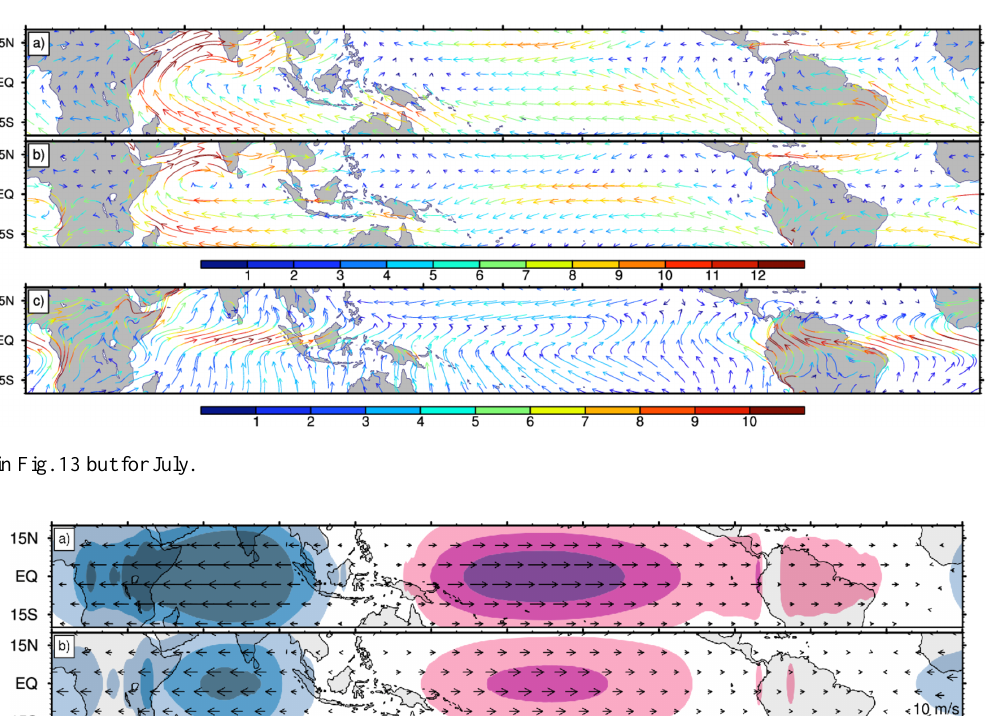
Figure 16. Climatological Kelvin wave in ERA Interim for July on (a) model level 27, at about 133hPa and (b) and model level 31, at about 229hPa. Isolines for the geopotential height are drawn every 10m, starting from ± 10m with positive values coloured in magenta and negative values in blue